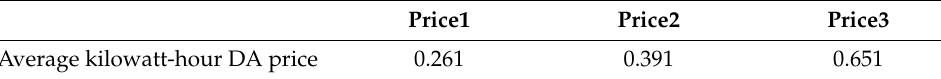
Figure 18. Electricity cost in the DA market based on 24-h average decomposition.